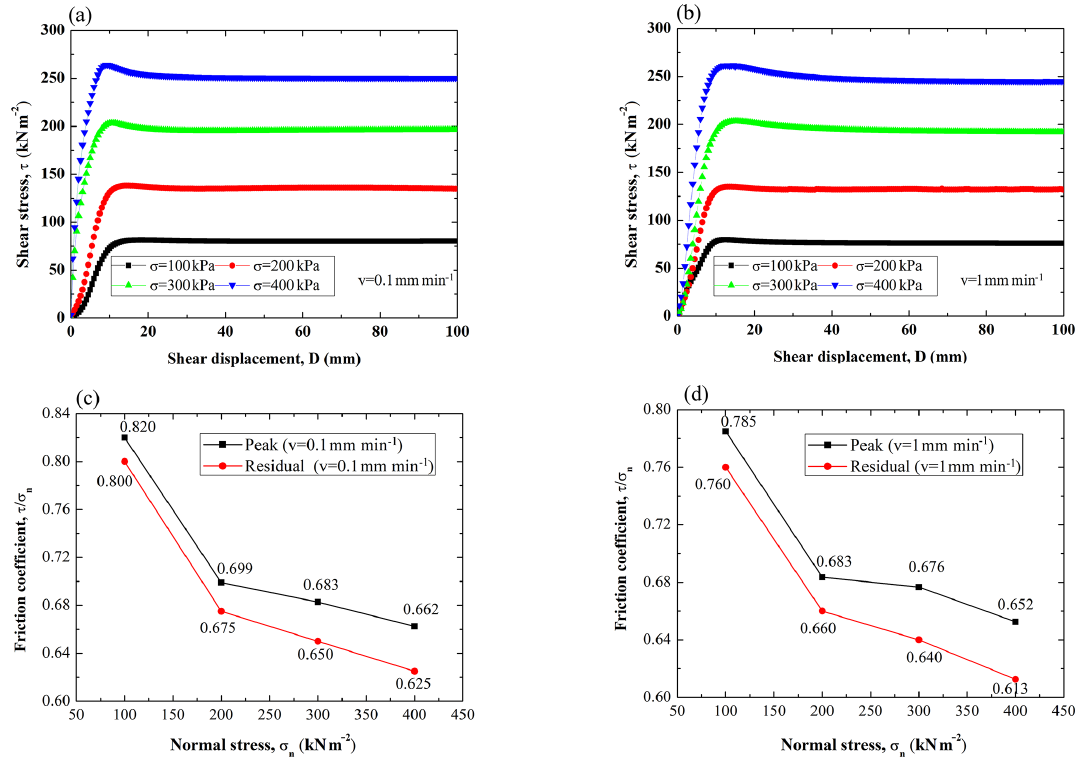
Figure 6. Shear behavior characteristics of the DBZ soil samples. (a) Relationship between shear stress and shear displacement. (b) Rela- tionship between friction coefficient and normal stress.